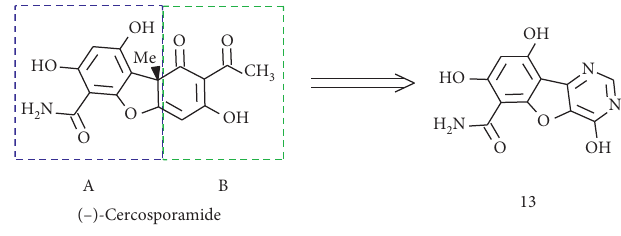
Figure 1: Design of target compound 13